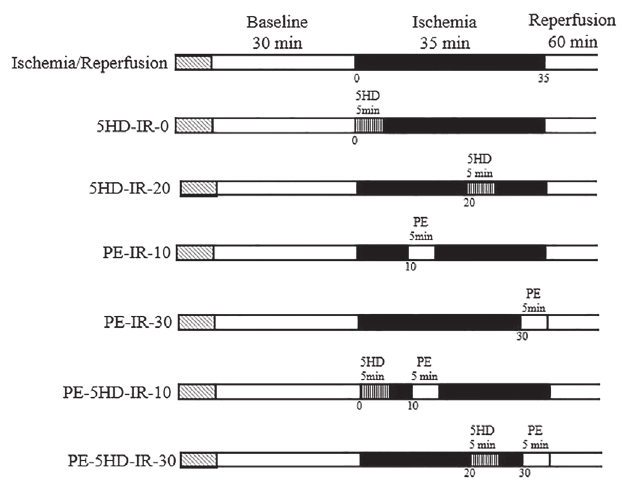
FIGURE 1 - Schematic illustration of the experimental groups: 5HD (5 hydroxydecanoate); PE (phenylephrine).